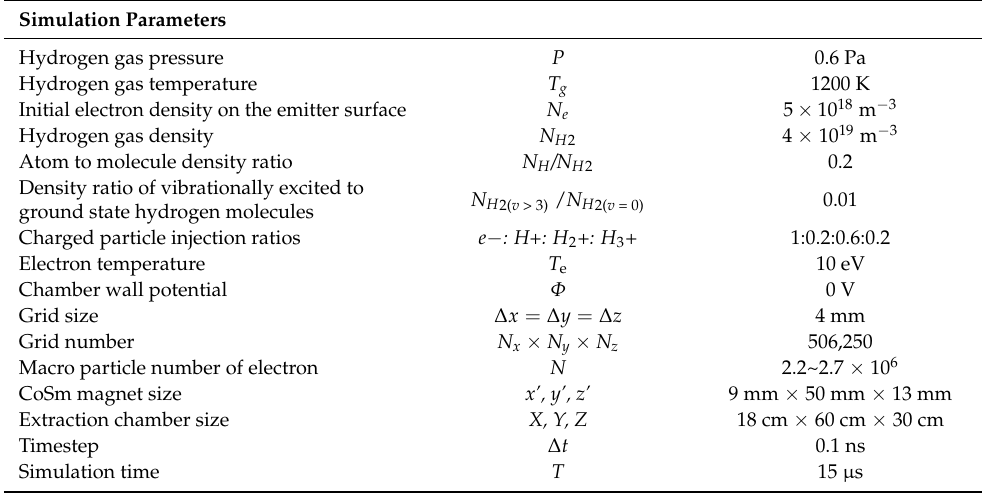
Table 1. Simulation parameters used in code [32–34].